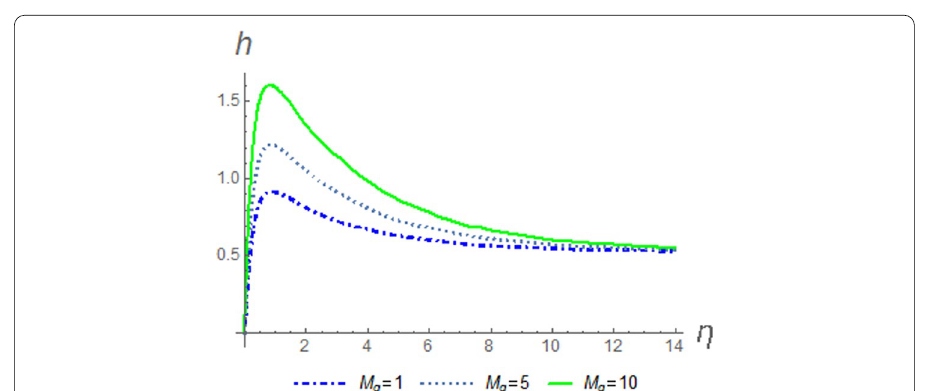
Fig. 3 Effect of M g on the velocity profile